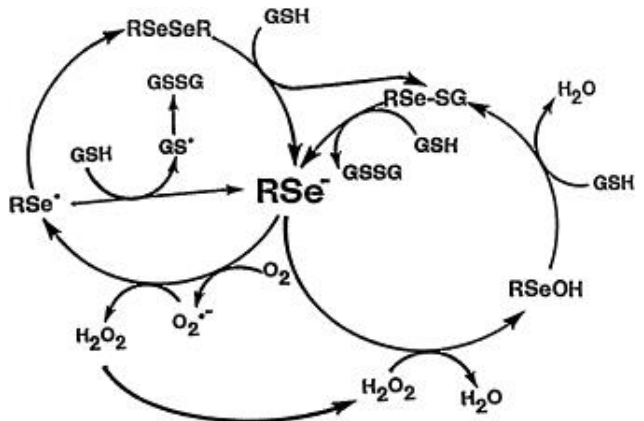
Figure 3. Redox cycling of selenium intermediates in the presence of GSH. Adapted from [27] and later republished [30]. Presented with permission from Taylor and Francis